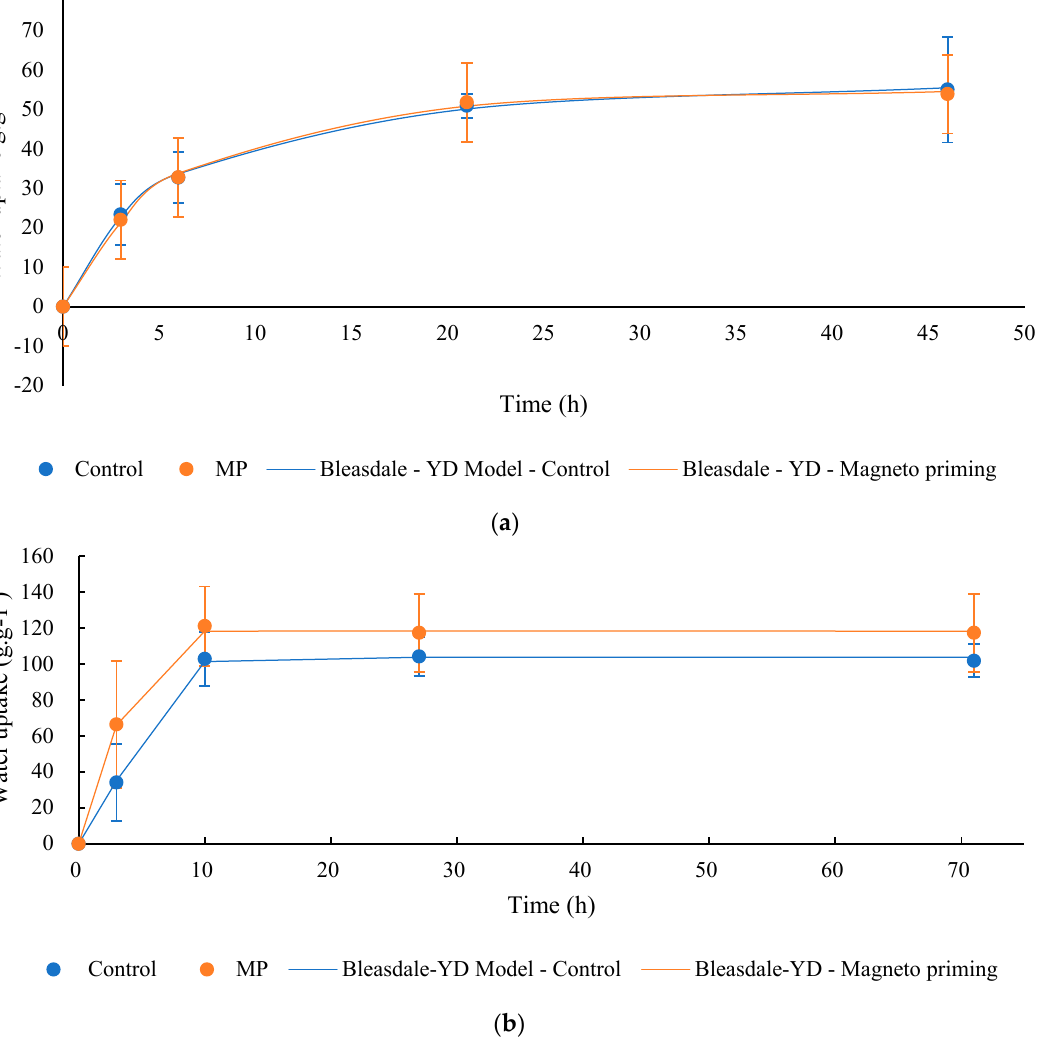
Figure 9. Water absorption curve of soybean seeds before and after exposure to magneto-priming. ( a ) Cultivar C01; ( b ) cultivar C02. The error bar indicates the standard deviation ( n = 3). Table 2. Parameters of the Bleasdale YD model given by y = x (A + b × θ ) − 1/ θ and adjusted for the water absorption curve in soybean seeds before and after exposure to magneto-priming (MP).